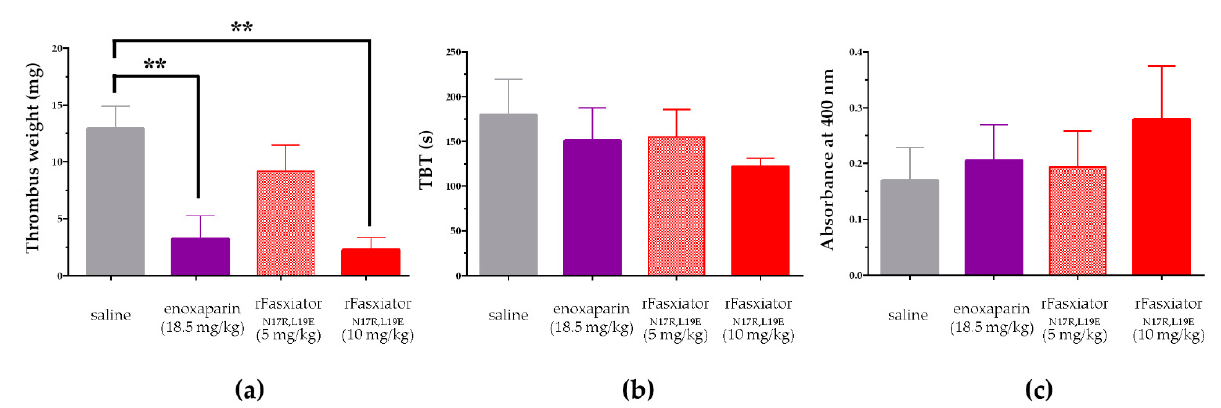
Figure 5. Inferior vena cava (IVC) ligation and tail bleeding model in mice. ( a ) Weight of thrombus from the inferior vena cava ligation of mice treated with saline (gray, n = 8), enoxaparin (purple, n = 8), 5 mg/kg rFasxiator N17R, L19E (red checked, n = 8), and 10 mg/kg rFasxiator N17R, L19E (solid red, n = 9). ** indicates that p ≤ 0.01 in Tukey’s multiple comparison test. ( b ) Bleeding time following transection of mice tail (TBT) treated with saline (gray, n = 6), enoxaparin (purple, n = 8), 5 mg/kg rFasxiator N17R, L19E (checkered red, n = 6), and 10 mg/kg rFasxiator N17R, L19E (solid red, n = 5). ( c ) Hemoglobin assay of blood collected from the transected tail of mice that were treated with saline (gray, n = 6), enoxaparin (purple, n = 8), 5 mg/kg rFasxiator N17R, L19E (red checkered, n = 6), and 10 mg/kg rFasxiator N17R, L19E (solid red, n = 5) 24 h before the procedure.